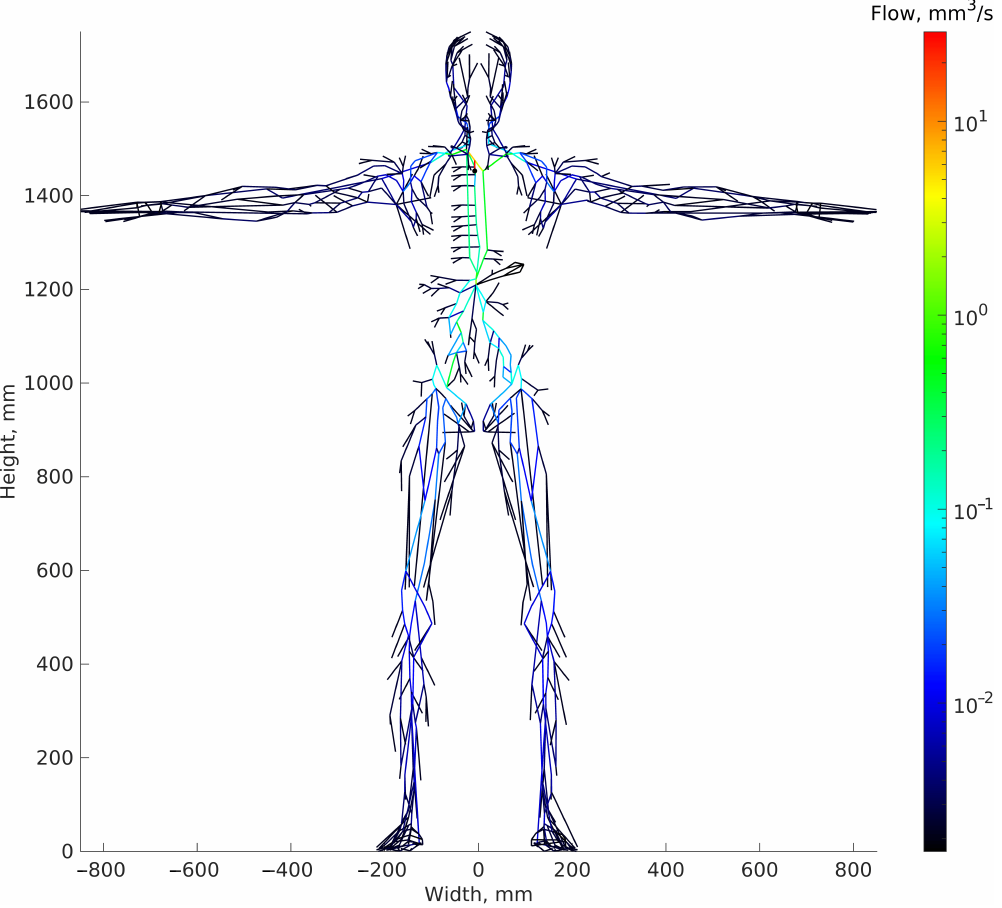
Figure 4. Steady-statedistribution of lymph flows in the HLS graph model. The output sink node is presented as black